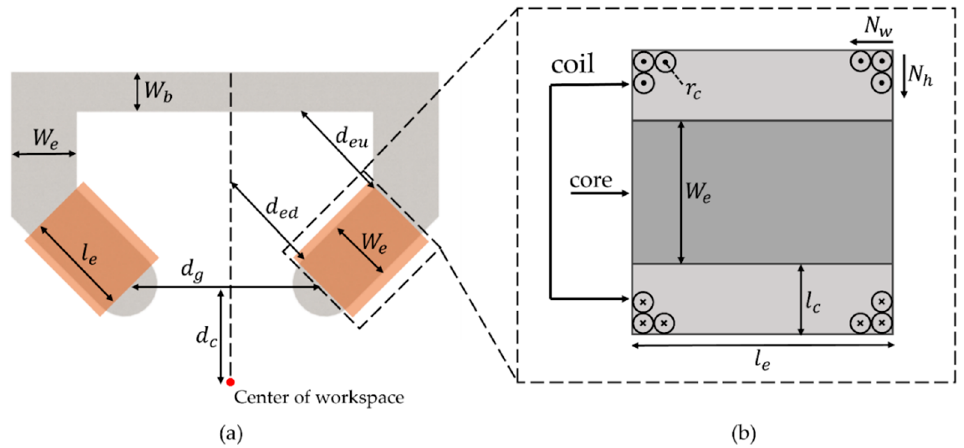
Figure 6. Design variables of the C-Mag: ( a ) design variables of the magnetic core; and ( b ) design variables of the